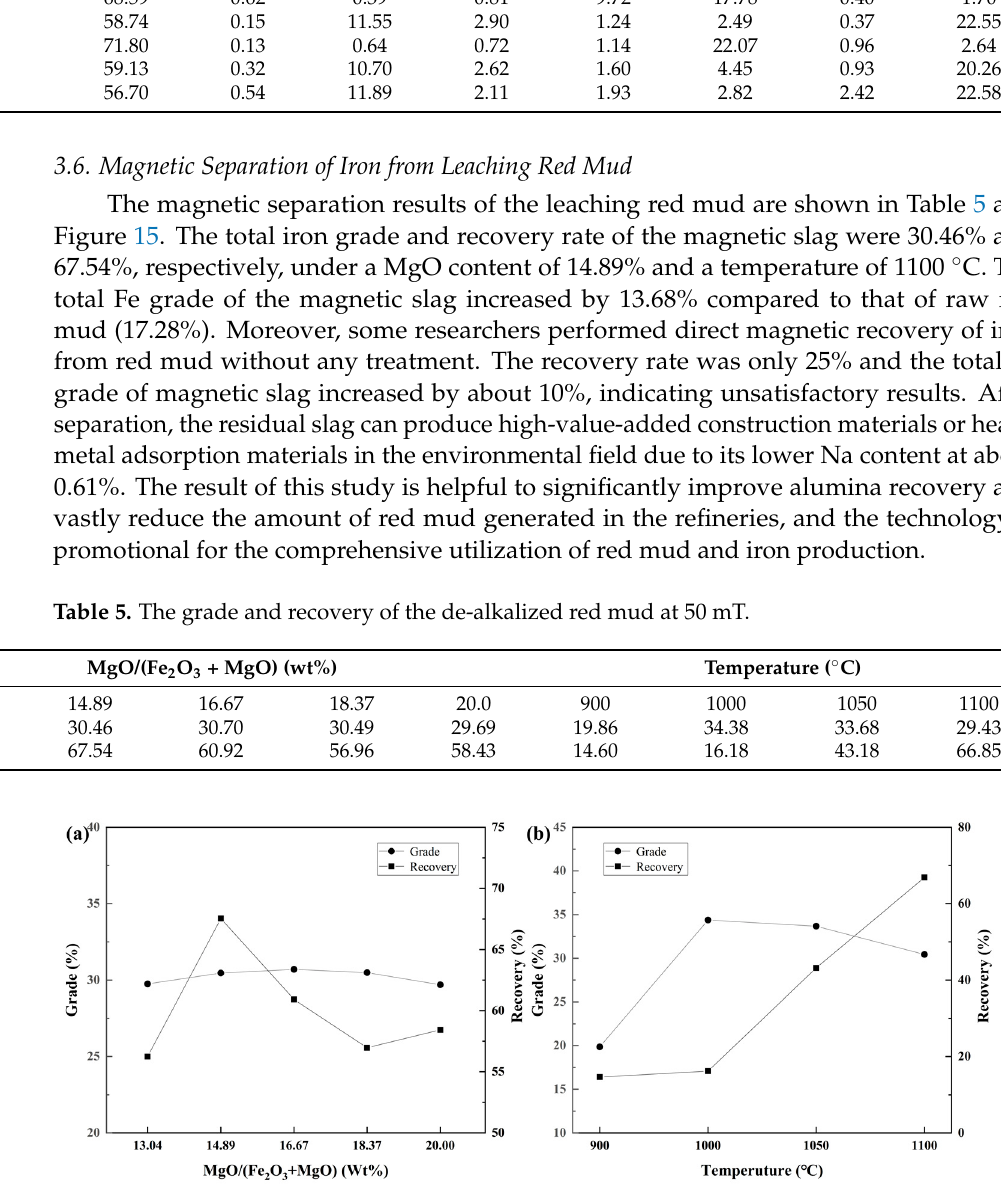
Figure 15. The grade and recovery of the de-alkalized red mud at 50 mT in different MgO/(Fe 2 O 3 +MgO) mass fraction ( a ) and temperature ( b ).